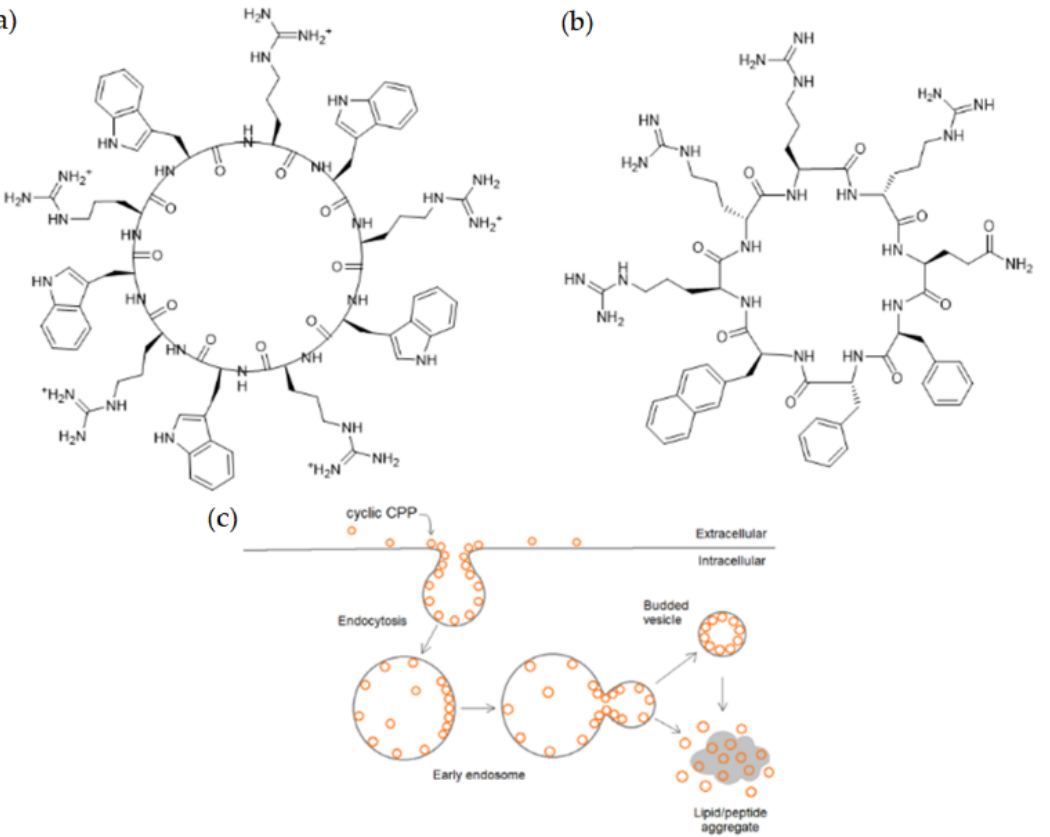
Figure 3. Chemical structure of ( a ) [WR]5 and ( b ) CPP12, and ( c ) the assumed endosomal escape mechanism of CPP12.